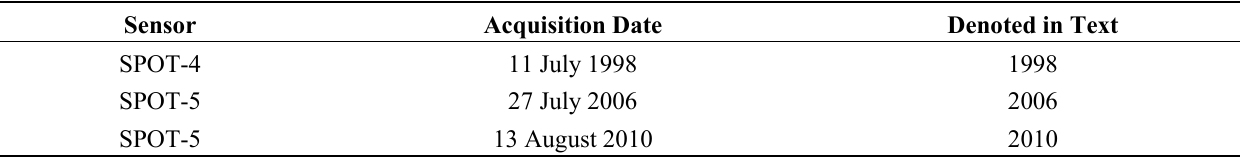
Table 1. Selected SPOT images covering southern Karakalpakstan in three time